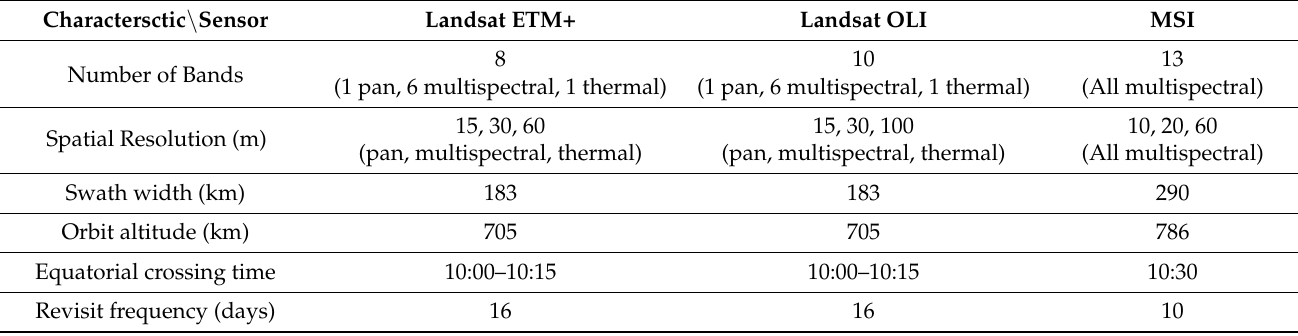
Table 1. Comparison of Landsat enhanced thematic mapper plus (ETM)+, Landsat operational land manager (OLI) and Sentinel multispectral imaging